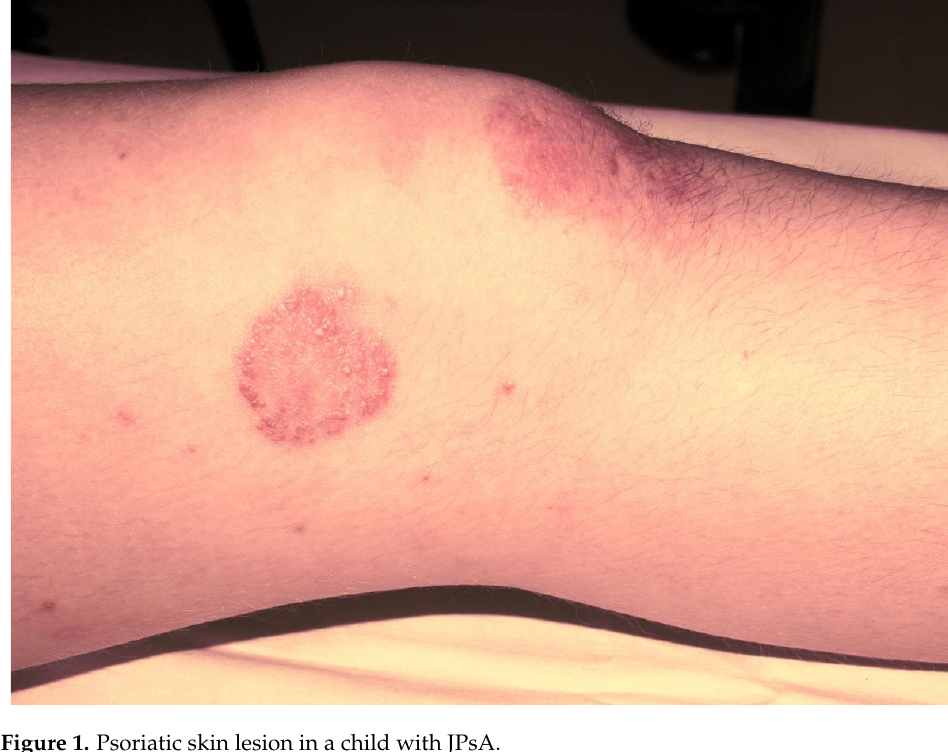
Figure 1. Psoriatic skin lesion in a child with JPsA.